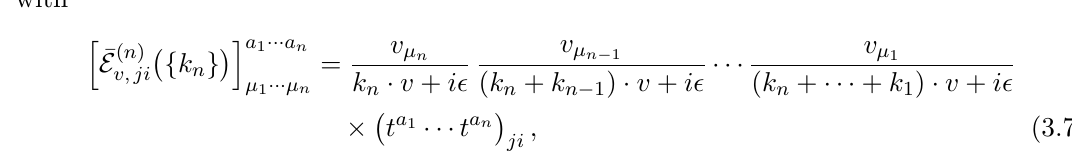
Figure 5 . Graphical representation of eikonal lines insertions, de(cid:12)ned by (3.5) and